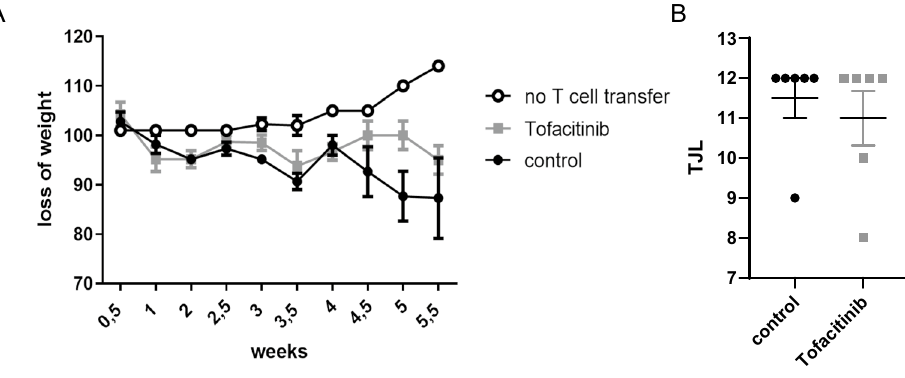
Figure 3. High-dose Tofacitinib treatment does not prevent weight loss and intestinal inflammation. Rag−/− mice were adoptively transferred with CD4 + CD25- wild-type cells Untreated Rag−/− mice were used as controls ( A ) Weight loss (N = 6 control mice, 6 Tofacitinib-treated mice and 4 mice without T cell transfer, one experiment). ( B ) Results of histological TJL (The Jackson Laboratory Score) scoring of colon